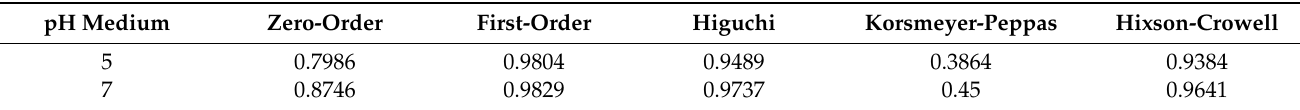
Table 5. Quality of the fit (expressed as squared correlation coefficient, R 2 ) for different kinetic models describing the release of α -arbutin from BMO-PUL nanoparticles. pH